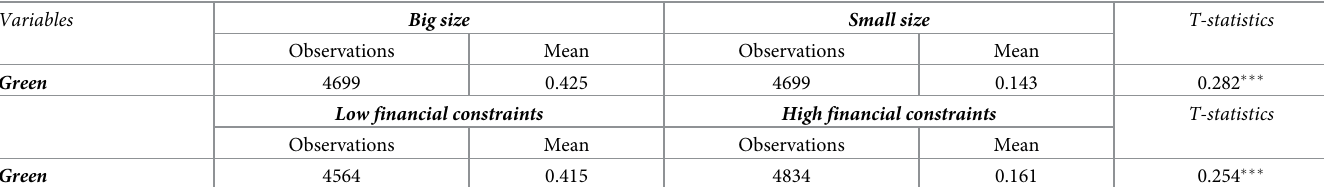
Table 2 presents the descriptive statistics of the variables. The mean value of Green is 0.278, and the minimum value, median value and maximum value are 0.000, 0.000 and 3.332 respec- tively. This result suggests exceed half polluting firms do not have green innovation output, which suggests the heterogeneity issue in the data sample. Table 3 shows the mean in our sub- samples based different firm characteristics, which suggest firms with big size and/or low financial constraints are more likely to conduct green innovation capability. The implementa- tion of the Ambient Air Quality Standard (2012) includes three stages, so we uses three vari- ables to proxy the pilot cities, namely, Treat1 , Treat 2 and Treat3 . The mean values of these Table 3. T-test for